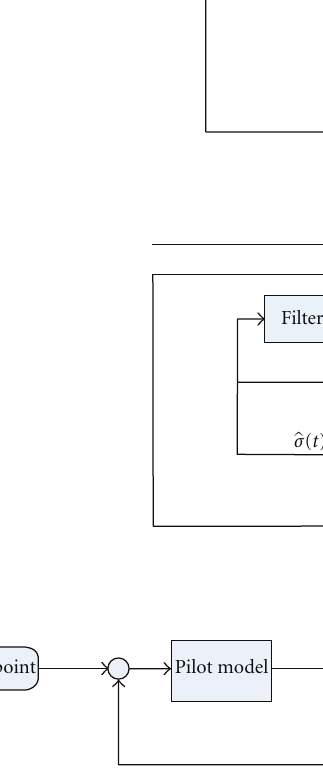
Figure 5: PIO delay margin detection